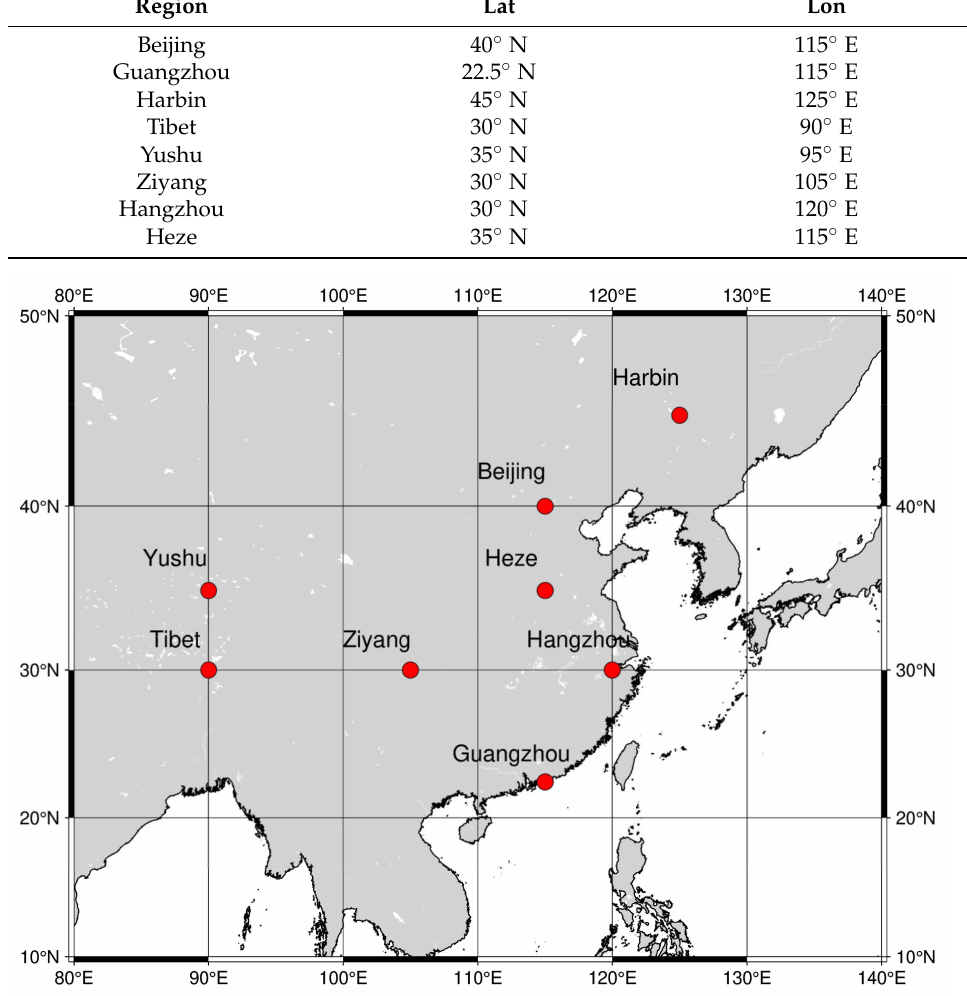
Figure 1. The information on the location of the eight regions on the